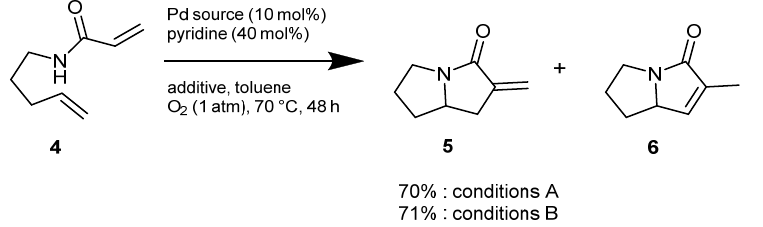
Scheme 2. Synthesis of pyrrolizidine and indolizidine via palladium-catalyzed aerobic oxidative cyclization.